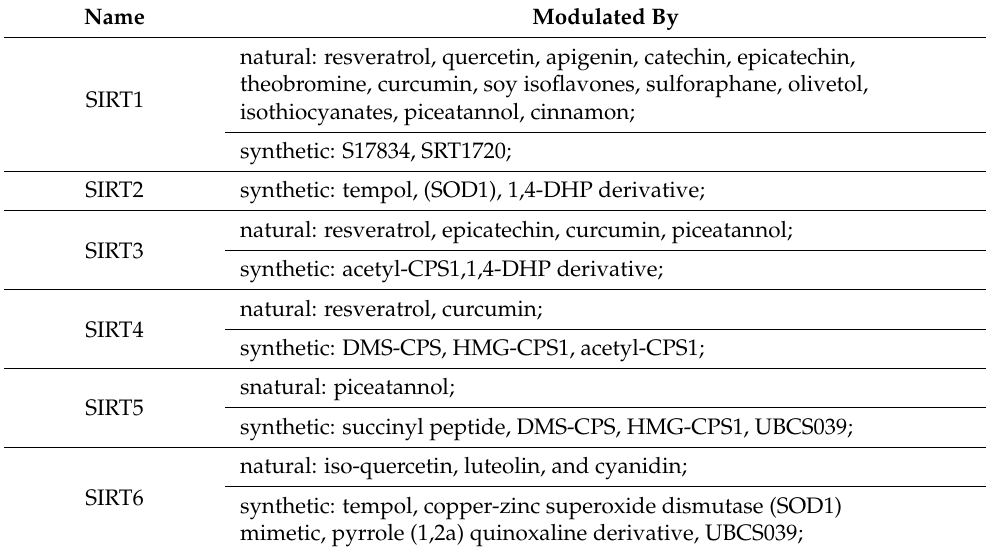
Table 2. The role of sirtuins in GC and known factors regulating their